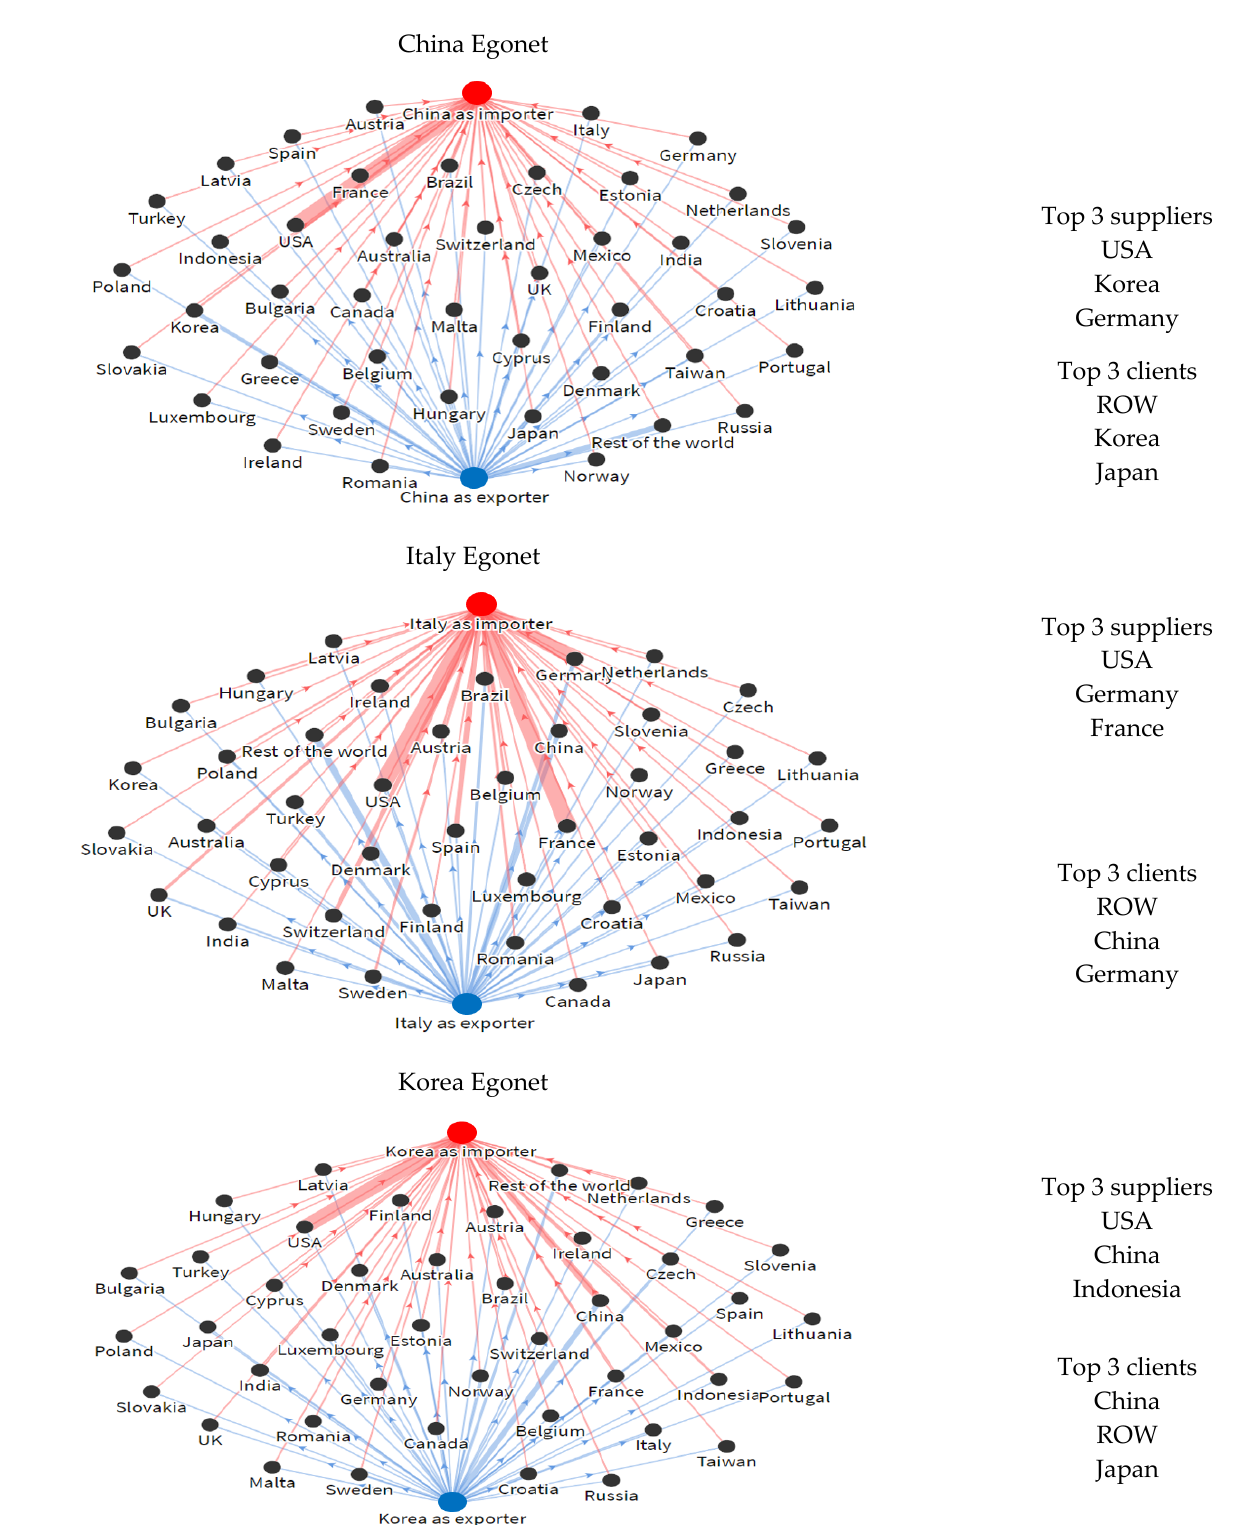
Figure 10. The egonets of China, Italy, and Korea in the Sectoral GVC network: “Manufacture of textiles, wearing apparel, and leather products”.